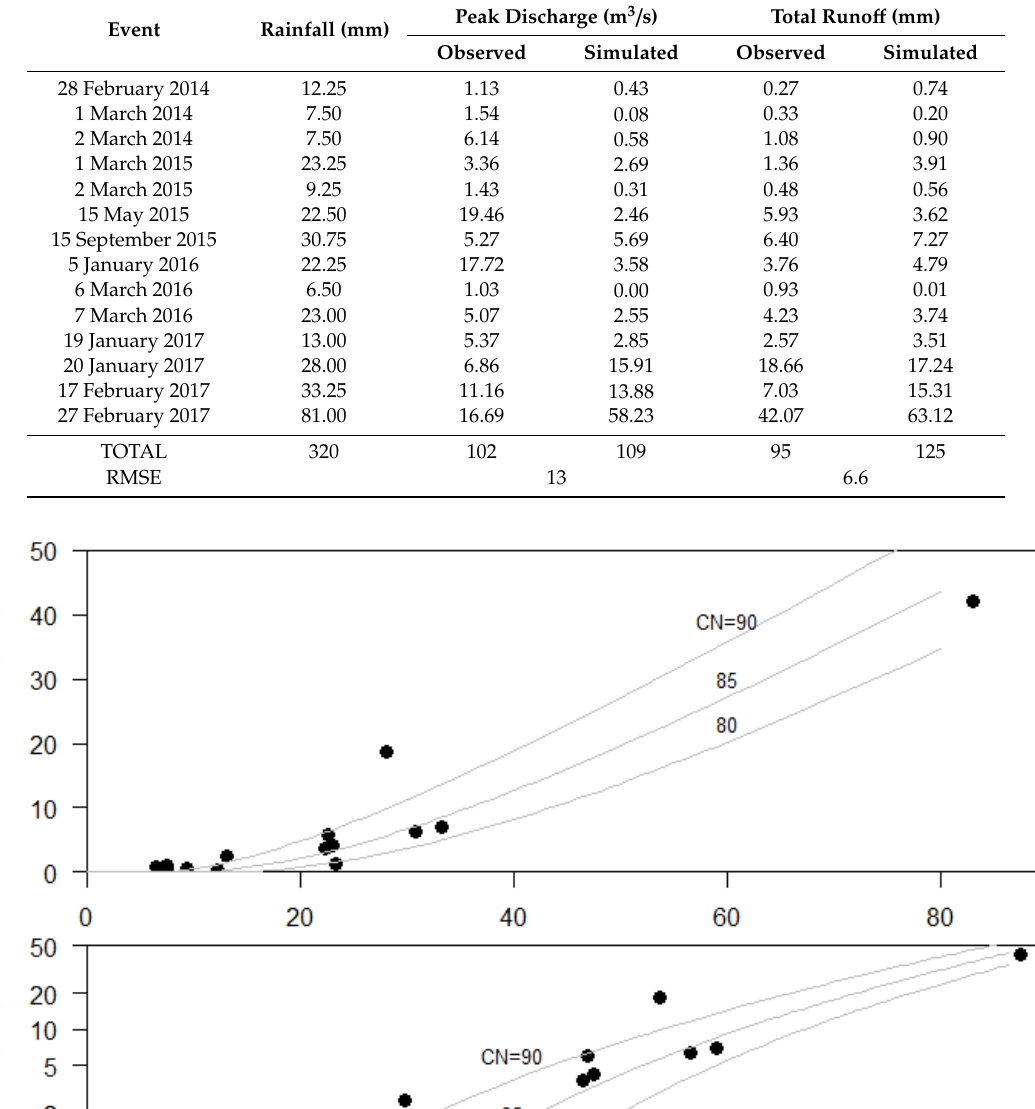
Figure 7. Relationship between observed and simulated total (a, mm per storm) and peak (b, m 3 /s) runoff. The solid lines are the 1:1 lines. 3.3. Simulated Sediment Production The SSC samples were collected from sub-watersheds with different soil characteristics. Fractional covers of soil types in the sub-watersheds draining to each SSC sample location vary from 20% to 100% erodible, non-cobbly soils (Lf soil type) (Figure 8). The observed SSC of the storm-water samples correlated with the AnnAGNPS-simulated SSC (Figure 8b), and modelled SSC correlated with the fraction of the sub-watersheds covered by Lf (Figure 8a and 8c), which highlight the influence of soil properties on the modelled sediment production. The modelled SSC values were